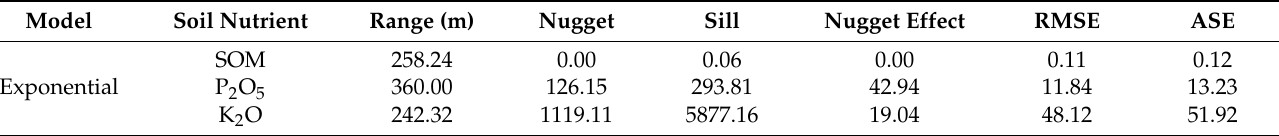
Table 8. Goodness-of-fit statistics values of the RF-OK models at the validation set for the soil nutrients. RMSEP MAEP Bias RPIQ Soil Nutrients R 2 val SOM